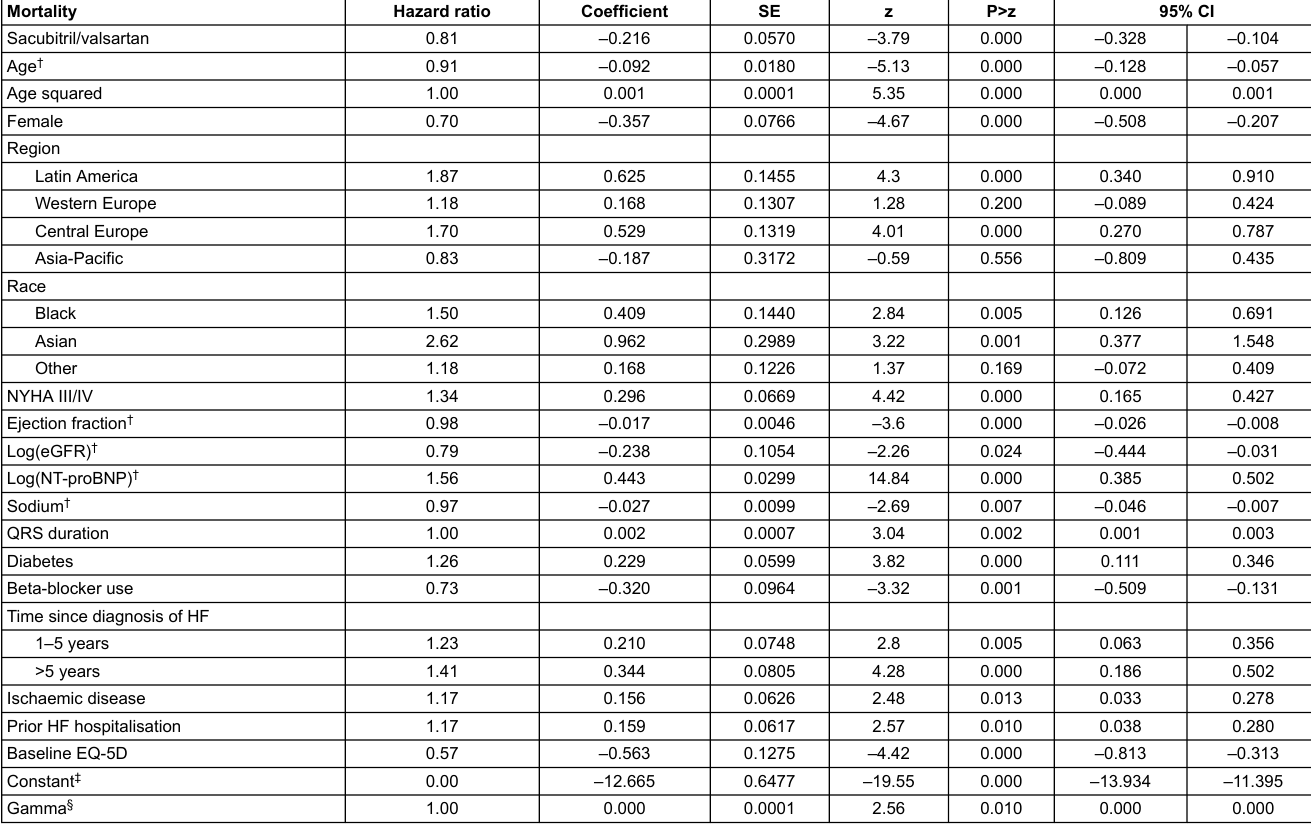
Table S3: Gompertz regression model for CV mortality (n = 8399). Mortality